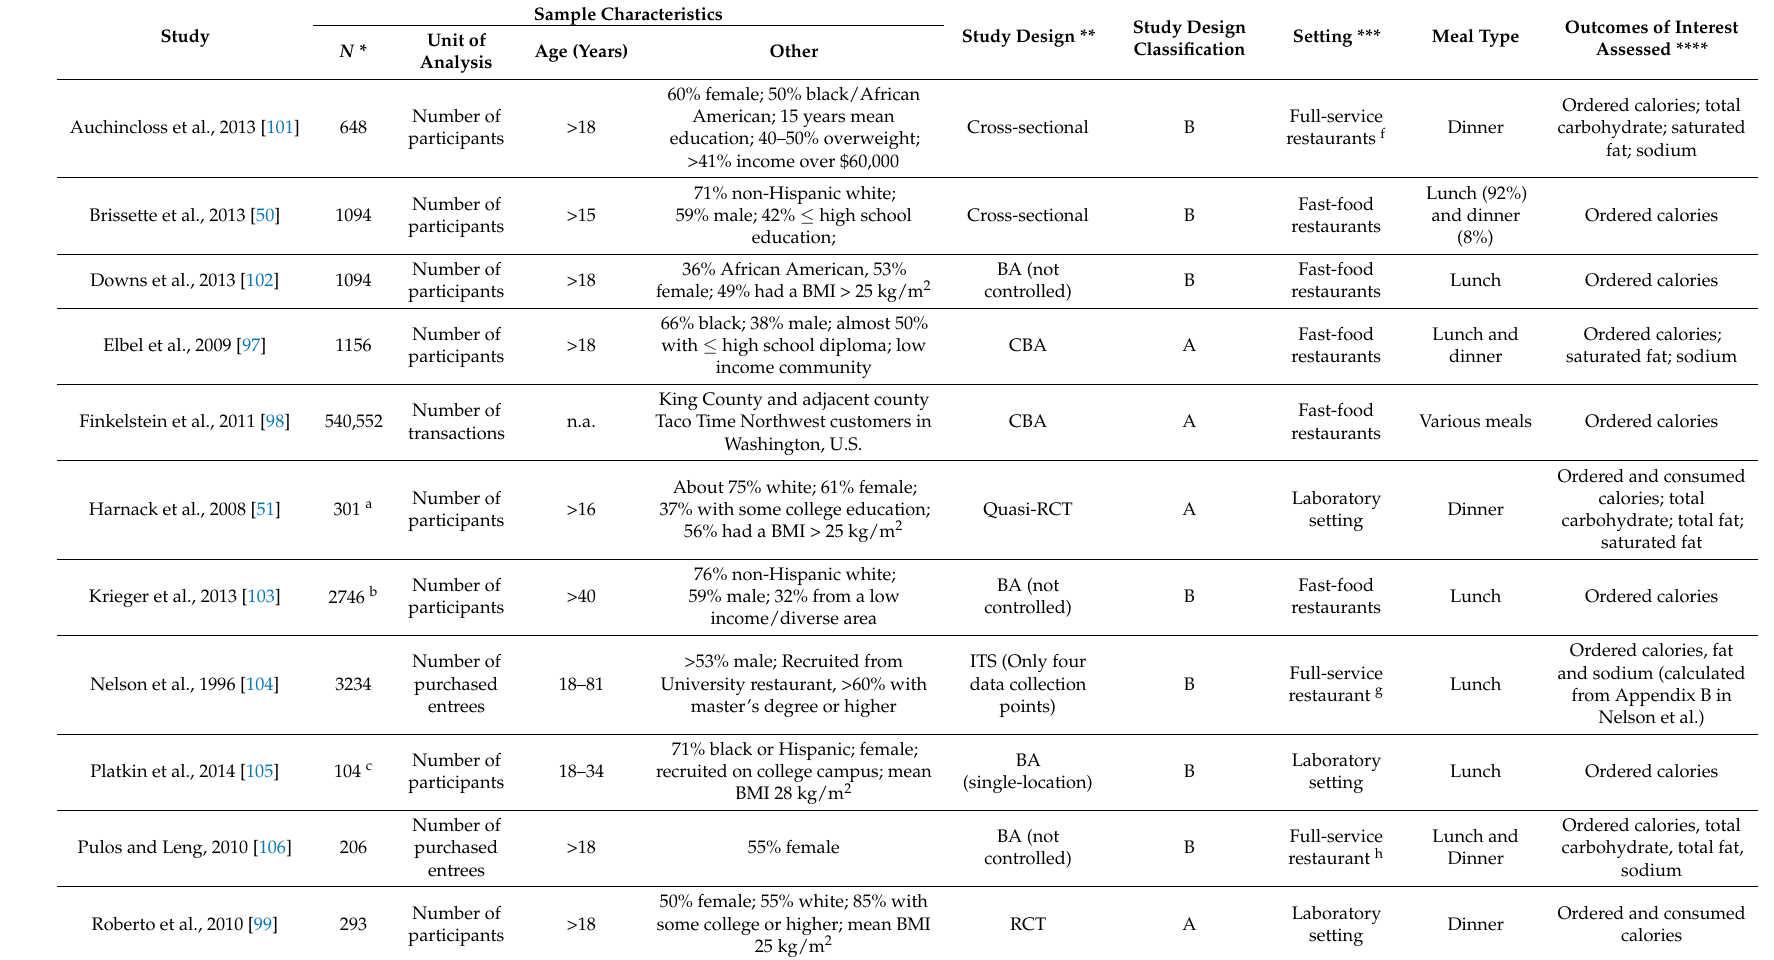
Table 2. Main characteristics of included